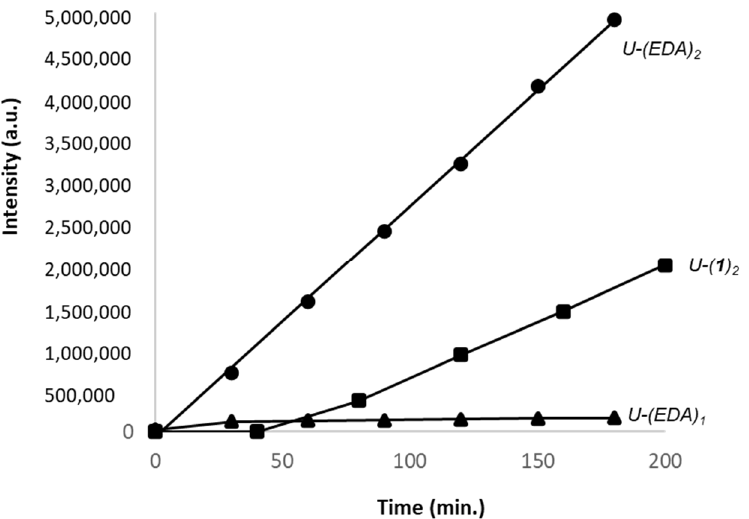
Figure 6. Kinetic of formation of the mono-adduct U-(EDA) 1 (triangles) and bis-adduct U-(EDA) 2 (circles) and U-( 1 ) 2 (squares) formed with EDA or 1 in the presence of 5fU. Due to the weak signal intensity of the mono-adduct U-( 2 ) 1 at 254 nm, it is not represented here. EDA or compound 1 (0.5 mM) was incubated with 5fU (0.5 mM) at 37 °C for 180 min in a methanol:ammonium formate buffer 5 mM, pH 4.5 mixture (40:60, v:v). The reaction products were analyzed by HPLC-DAD and the surfaces of the pics corresponding to the mono- and bis-adducts were recorded at 254 nm.